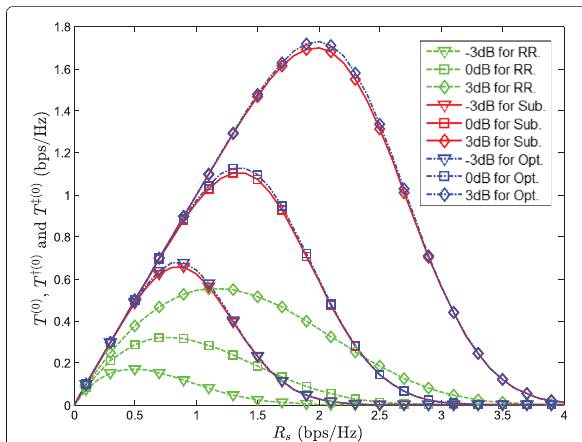
Fig. 4 Comparison of best-case-EST for round-robin scheme (RR.), suboptimal scheme (Sub.), and optimal scheme (Opt.) with different cases of SNR